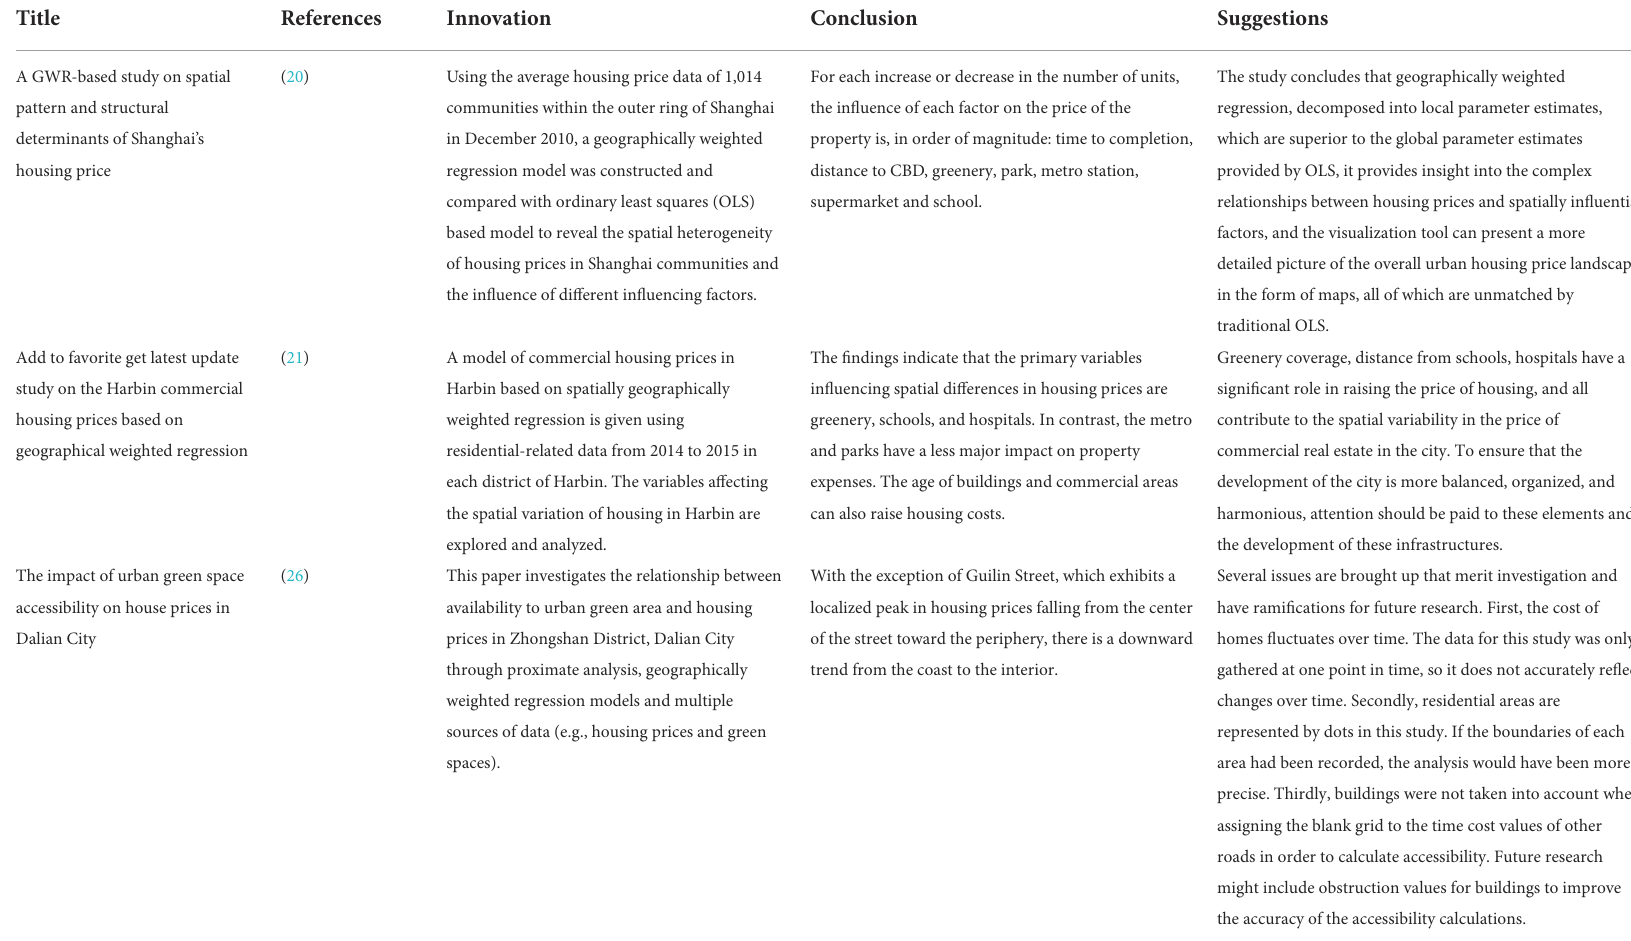
TABLE 2 Literature review of the geographically weighted regression